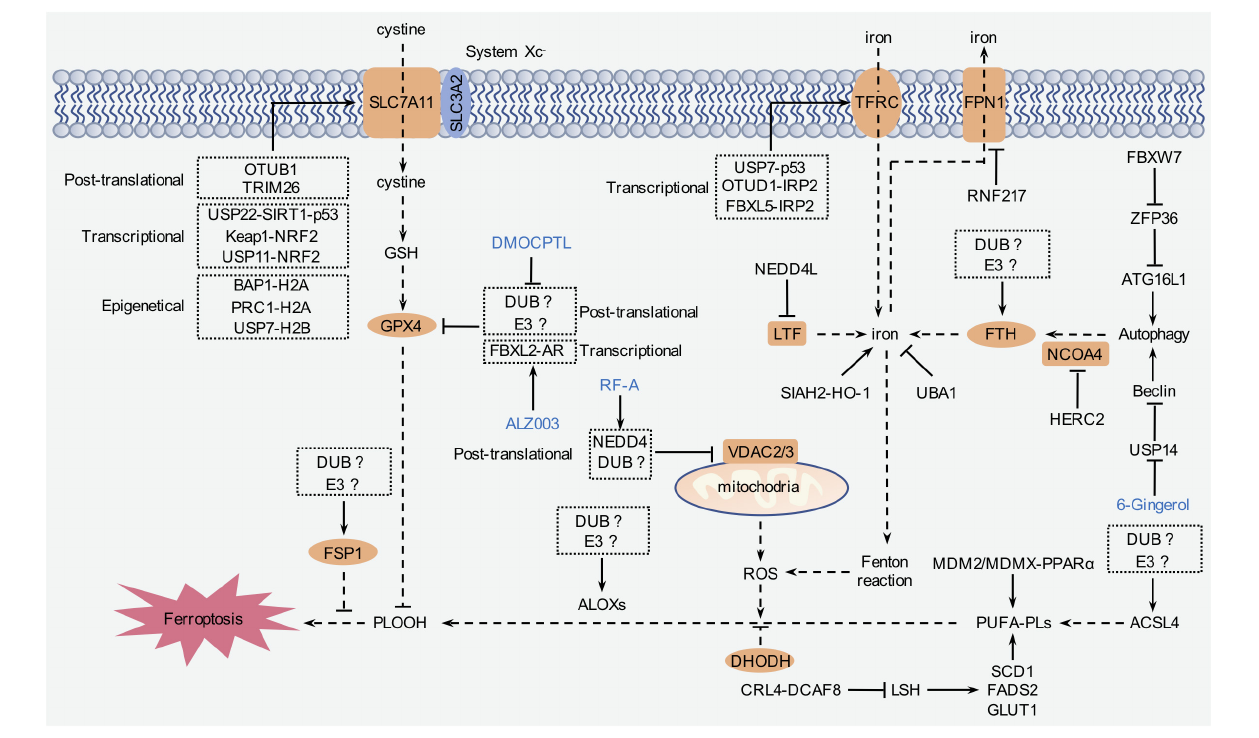
FIGURE 5 | The regulation mechanism of ferroptosis by ubiquitination. Ferroptosis is tightly relevant to amino acid, iron, and lipid metabolism. Intracellular labile iron is capable of triggering lipid peroxidation to induce ferroptosis. System Xc - transporter-mediated cystine uptake, which, in concert with GPX4, can reduce the cytotoxic lipid peroxides and inhibit ferroptosis. In addition, FSP1 and DHODH inhibit ferroptosis independent of GPX4. Modulation of these pathways by ubiquitination contributes to ferroptosis